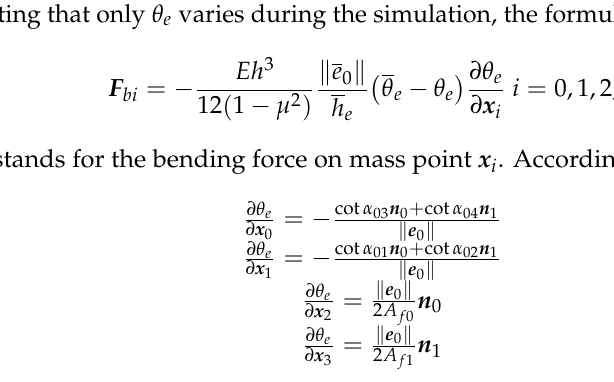
→ x 1 x 0 f 1 . The other